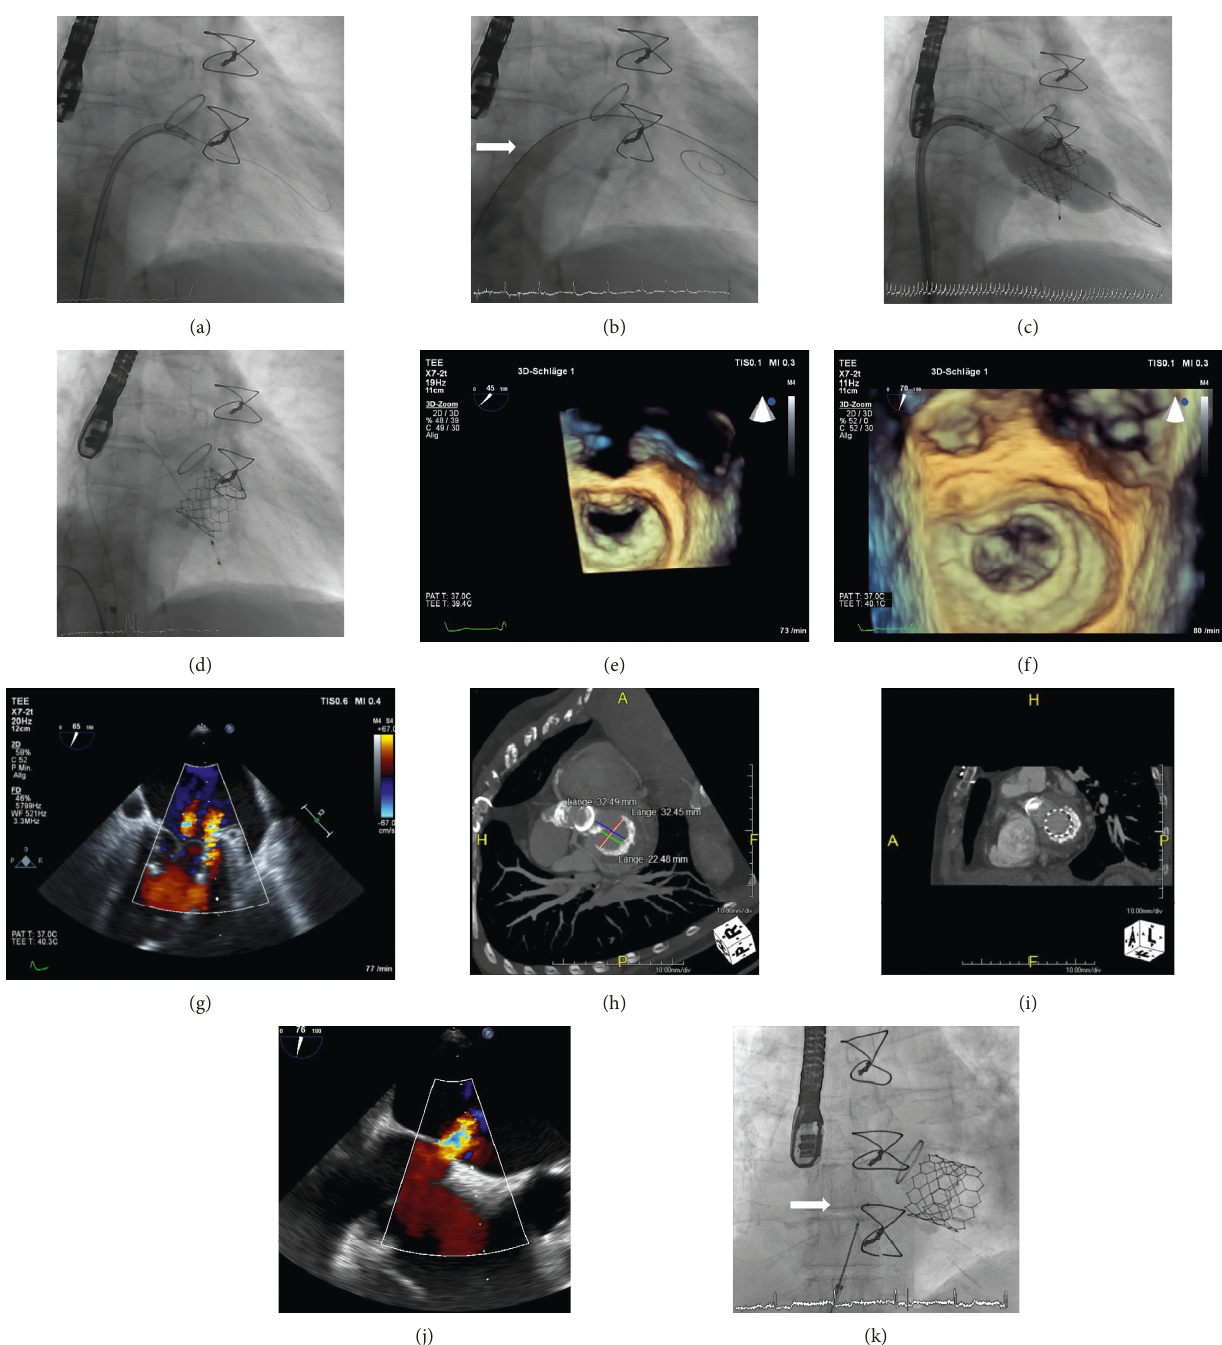
Figure 1: TMVI-MAC: (a) fluoroscopy shows a 0.035-inch J-guide inserted through the mitral valve in the left ventricle via a steerable guiding catheter (Agilis, 8,5F, Abbott, Illinois, USA). (b) Fluoroscopy shows balloon dilatation (Osypka VACS II 12 × 60mm Balloon, Osypka AG, Germany, white arrow) of the interatrial septum over an Amplatz Super Stiff guidewire (Boston Scientific) to create an artificial atrial septum defect prior to insertion of the prosthesis into the left atrium. (c) Fluoroscopy shows the implantation of a 29mm Edwards SAPIEN 3 (ES 3) prosthesis into the heavily calcified native mitral valve. (d) Fluoroscopy shows the final result after implantation of the ES 3 prosthesis into the calcified native mitral valve. (e) 3D- TEE shows the native mitral valve with a heavily calcified native mitral ring prior to TMVI (view from left atrium). (f) 3D-TEE shows the result after TMVI of the 29mm ES 3 prosthesis into the advanced mitral annular calcification (MAC). (g) 2D- TEE with color duplex shows only minimal paravalvular and valvular regurgitation after implantation of the ES 3 Prosthesis into the MAC. (h) Cardiac CT-scan shows the exact dimensions of the calcified mitral valve prior to implantation. (i) Cardiac CT-scan shows the final result after TMVI into MAC. (j) 2D-TEE with color duplex shows a large iatrogenic atrial septal defect (ASD) with clinically relevant right-to-left cardiac shunt. (k) Fluoroscopy shows successful transcatheter implantation of an Amplatzer Septal Occluder (Abbott, Illinois, USA) into the ASD (white